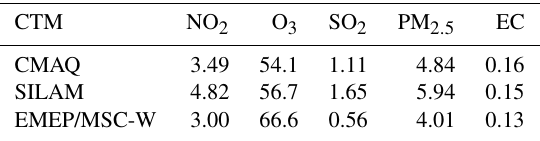
Table 2. Spatial averages of the annual mean concentrations of NO 2 , O 3 , SO 2 , PM 2 . 5 and EC in µgm − 3 for the study domain (Baltic Sea region as in Fig.